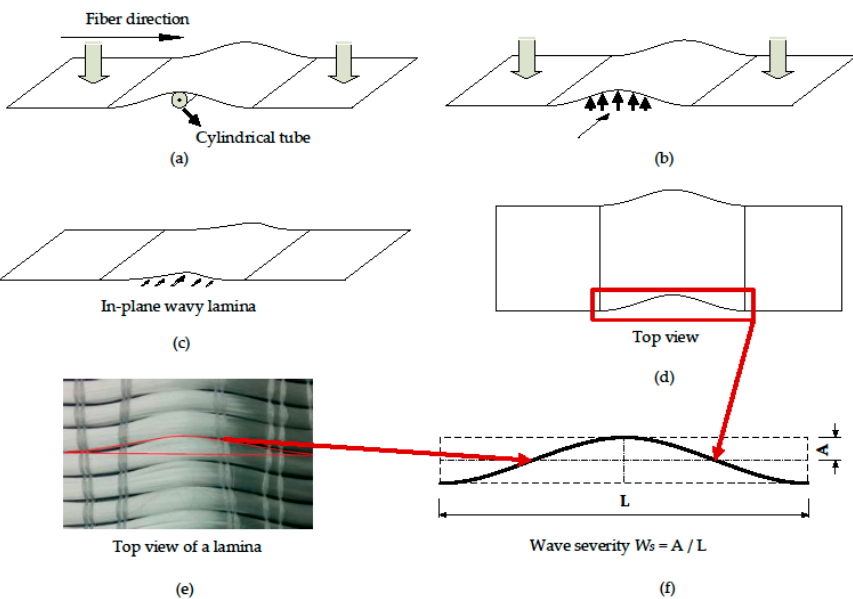
Figure 1. A scheme showing the procedure to induce an in ‐ plane wave in a lamina: ( a ) inducing an out ‐ of ‐ plane wave with the help of a cylindrical tube, ( b ) out ‐ of ‐ plane fibers after the removal of the tube, ( c ) applying in ‐ plane shear to make fibers in ‐ plane, ( d ) a top view of the lamina, ( e ) preview of the in ‐ plane wavy fibers, and ( f ) definition of fiber wave severity.